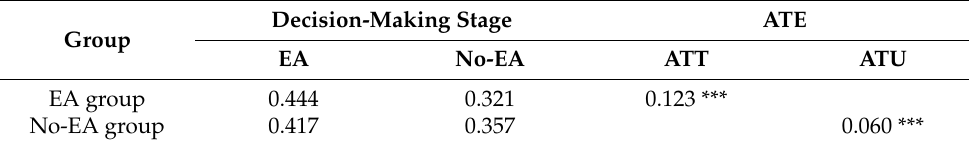
Table 5. Results of ESR model.